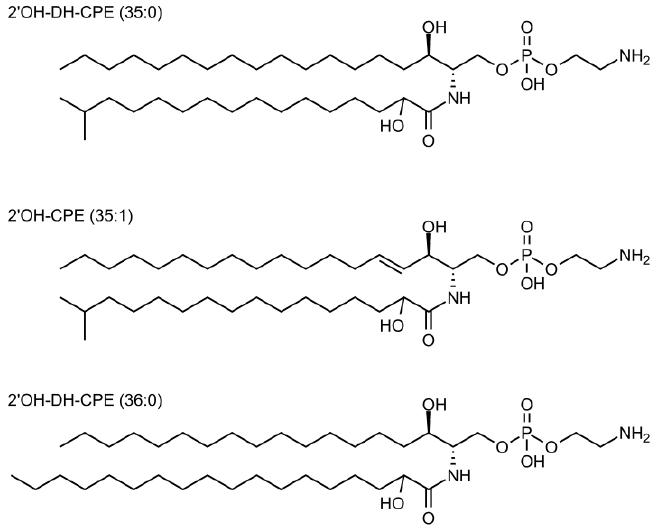
Figure 2. Structures of most representative Porphyromonas gingivalis CPE